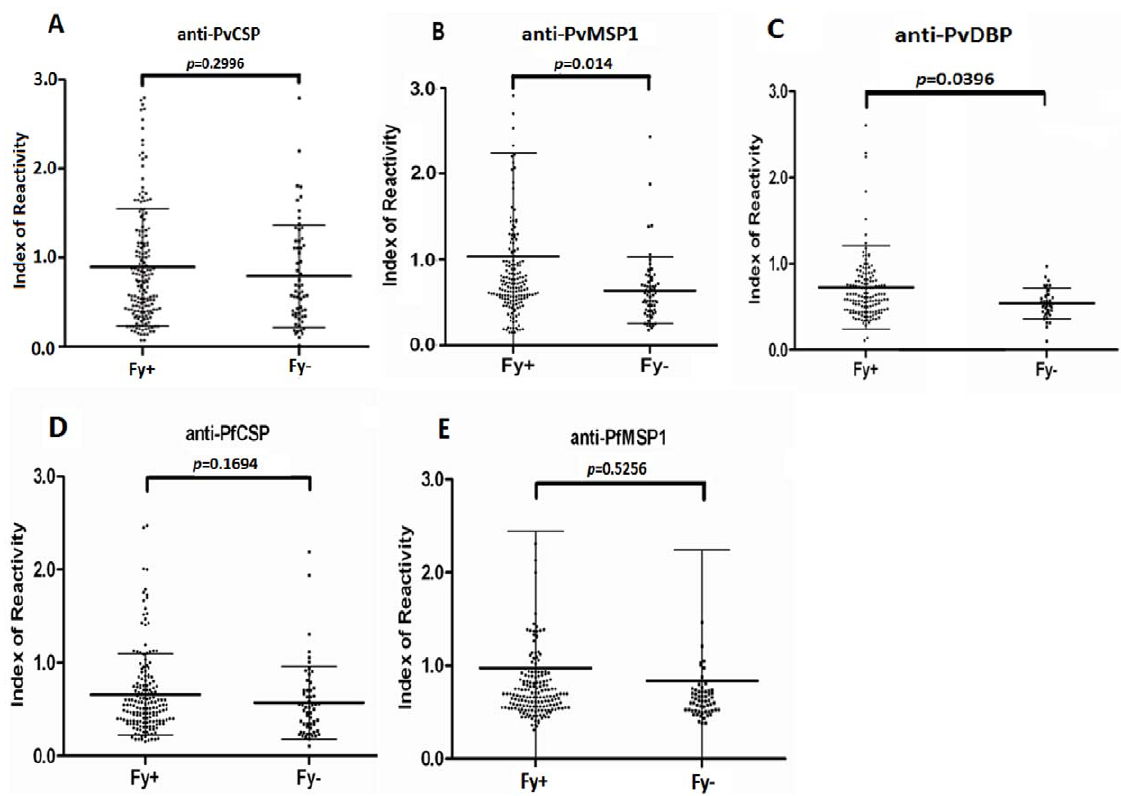
Figure 2. Antibody responses against P.vivax erythrocytic antigens are significantly greater in Fy + than in Fy 2 individuals. Immune recognition of P. vivax sporozoite antigen (A: PvCSP) and blood stage antigens (B: PvMSP1, C: PvDBP), or P. falciparum sporozoite antigen (D: PfCSP) and blood stage antigen (E: PfMSP1) by sera of Fy + ) and Fy 2 donors were assessed by ELISA. Values are expressed as Index of Reactivity (IR) that is calculated as test OD divided by cut-off OD. The cut-off OD is the average OD value of US donors (with no prior exposure to malaria) + 3 SD.